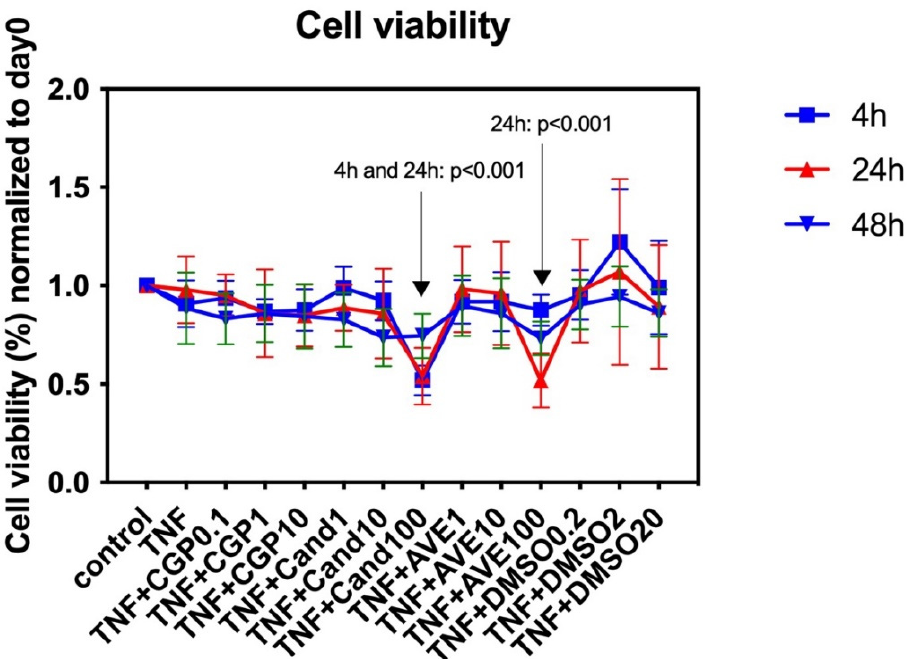
Figure 5. Cell metabolic activity analysis in human NP cells for candesartan (“Cand”) (1 µ M, 10 µ M, 100 µ M), the MAS-receptor agonist AVE 0991 (“AVE”) (1 µ M, 10 µ M, 100 µ M), and the AGTR2- receptor agonist CGP-42112A (“CGP”) (0.1 µ M, 1 µ M, 10 µ M) with 4 h, 24 h, and 48 h of exposure. DMSO (0.1 µ L/mL, 1 µ L/mL, 10 µ L/mL; shown in µ L volume on the x -axis) was used as the solvent control. Cell viability normalized to the baseline (day 0/timepoint of drug exposure) is shown. n = 2 biological replicates and n = 3 technical replicates per donor were assessed. Mean and standard deviation (SD) are shown.